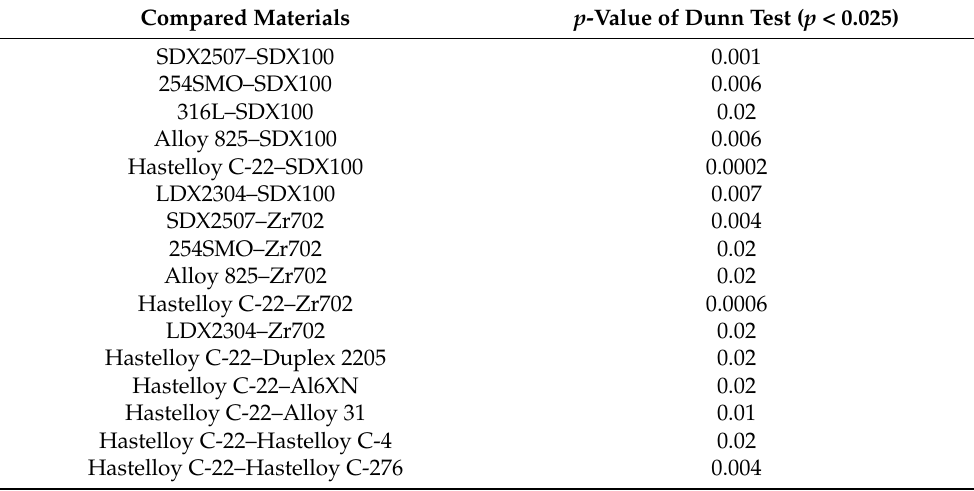
Table 4. Results of the Dunn test for the KOH/NaOH mixture with high chloride content. Compared Materials p -Value of Dunn Test ( p <